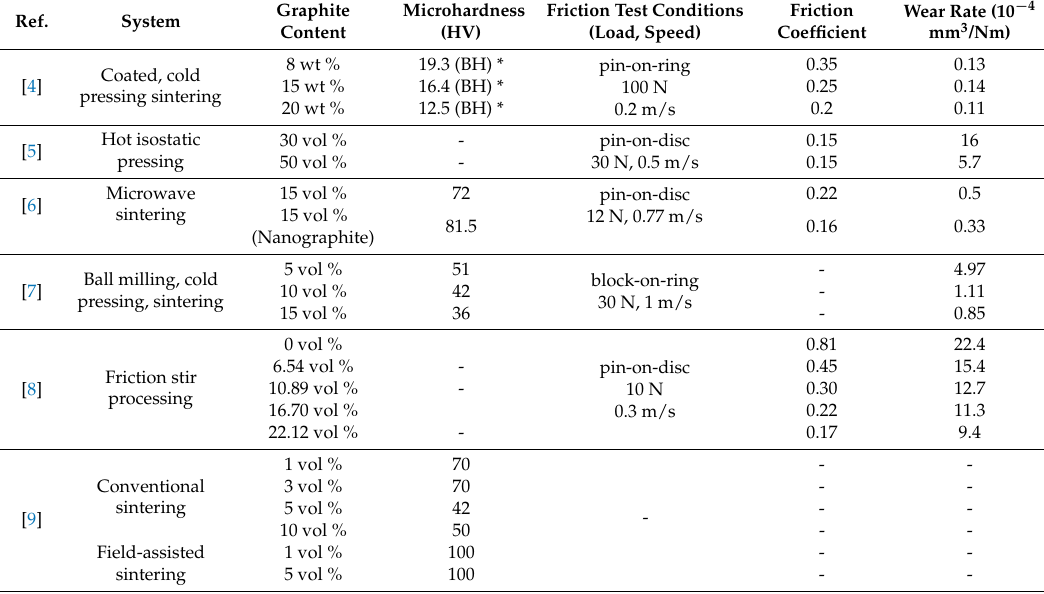
Table 1. Microhardness, average friction coefficient, and wear rate for copper–graphite composites. HV and BH stand for Vickers and Brinell hardness number, respectively. * Microhardness is given in BH for